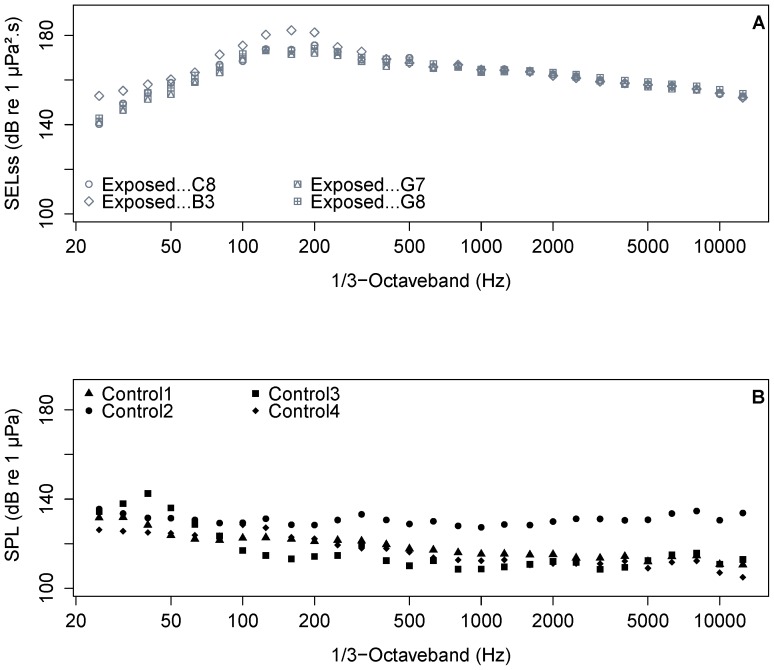
Measured frequency spectra in the presence and absence of pile driving.Mean SELss (A) of the total recorded piling strikes versus 1/3 octave bands and SPL (B) of the control groups versus 1/3 octave bands. C8, B3, G7, G8 are the groups exposed to pile-driving; Control 1–4 are the control groups.